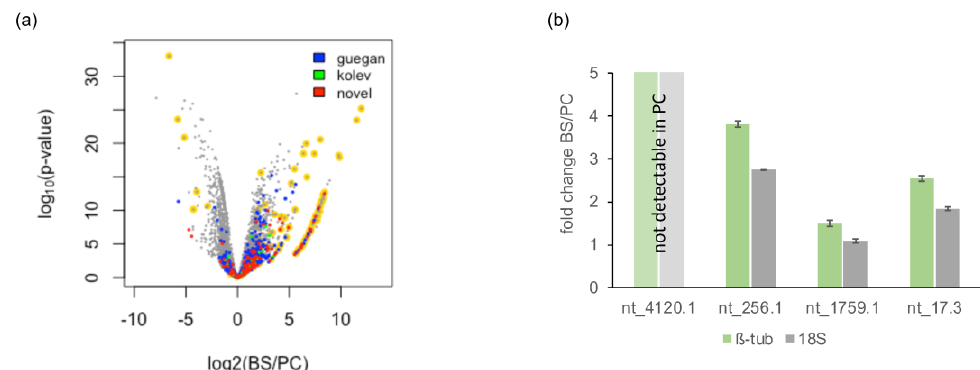
Figure 7. Differential expression of lncRNAs. ( a ) Volcano plot of differential gene expression between bloodstream-stage (BS) and procyclic-stage (PC) T. brucei . Novel lncRNA (this study) are in red. LncRNAs described in Guegan et al., 2022, and Kolev et al., 2010 [15,16] are in blue and green. Transcripts for the stage-specific cell-surface proteins procyclin, VSG, ISG and expression site-associated genes (ESAG) are highlighted in yellow. ( b ) Quantitative (q)RT-PCR results of transcript levels of the four novel lncRNAs: nt_4120.1, nt_256.1, nt_1759.1, and nt_17.3. Fold changes (BS/PC) were estimated using the DCT method with either 18S rRNA (18S, grey) or ß-tubulin (ß-tub, green) as controls. Error bars are ±1 SD. For nt_4120.1, no signal was detected in PC trypanosomes.